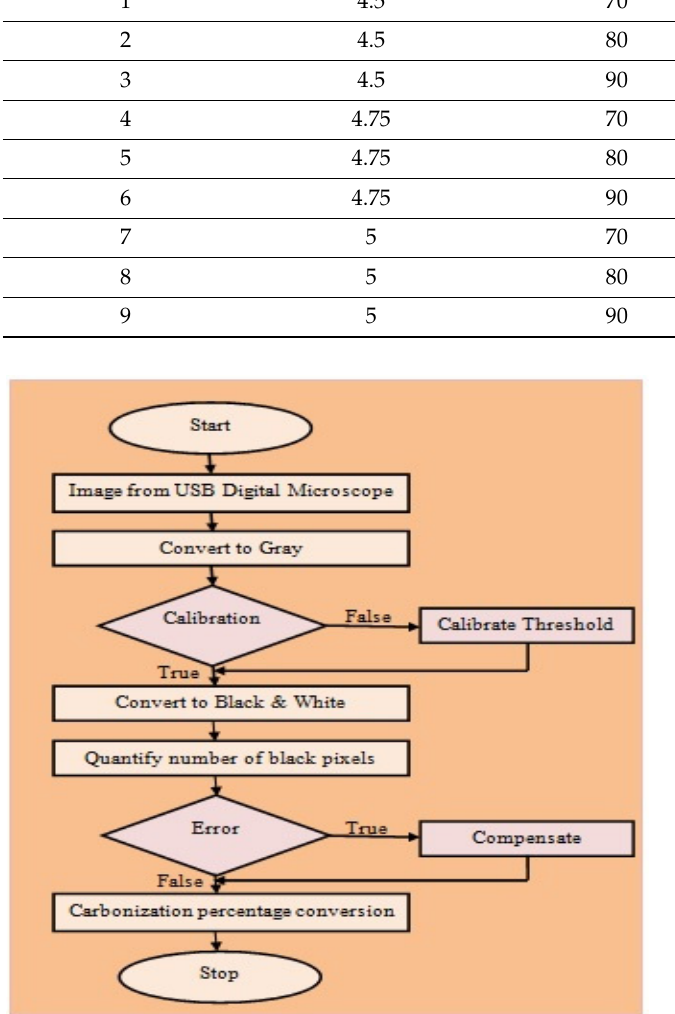
Figure 3. Flowchart for image